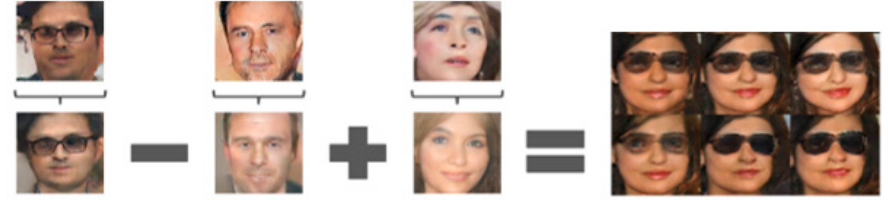
Figure 41. Example of smile arithmetic and arithmetic for wearing glass using GAN: a man with glasses minus man without glasses plus woman without glasses equal to woman with glasses.